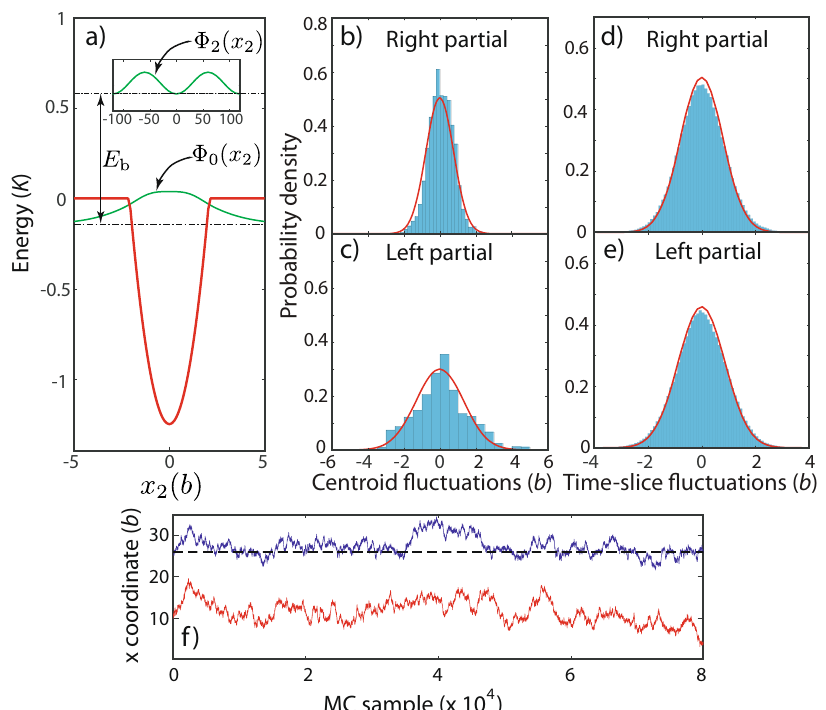
Fig. 4 Eigenstates for effective 1D model with pinning potential and corresponding PIMC results. a Ground-state and second excited-state probability densities for x 2 (green lines) for truncated and shifted harmonic potential (red line) with k i = 4.25 × 10 − 2 K Å − 2 and U 0 = 1.25 K. Horizontal dashed lines depict energy levels of states. Histograms in b and c describe fl uctuations in atomistic dislocation centroid positions of the right (pinned) and left partial dislocations, respectively, as obtained from Fourier-smoothed atomistic paths for T = 0.267 K. Histograms in d and e depict statistics of atomistic dislocation time-slice deviations with respect to centroids for right and left partials, respectively, T = 0.267 K. Red lines in b – e correspond to statistics obtained from 8 × 10 4 independent paths for the effective 1D model. f Centroid positions for variables x 1 (red line) and x 2 (blue line) from PIMC simulation for shifted and truncated pinning potential at T = 1.067